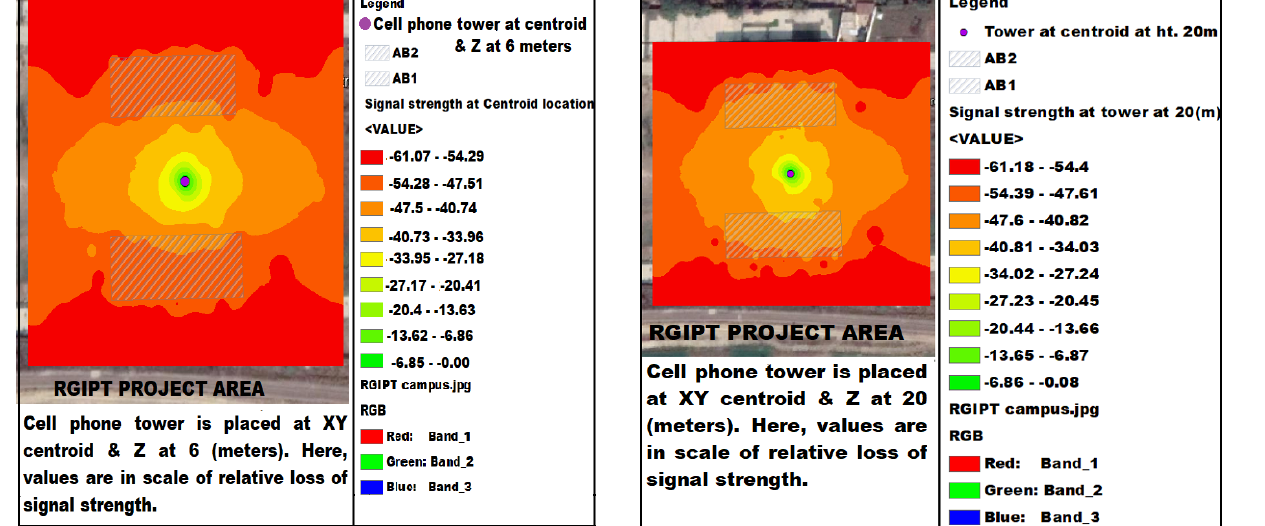
Figure 19. Cell phone tower at XY Centroid and Z at 20